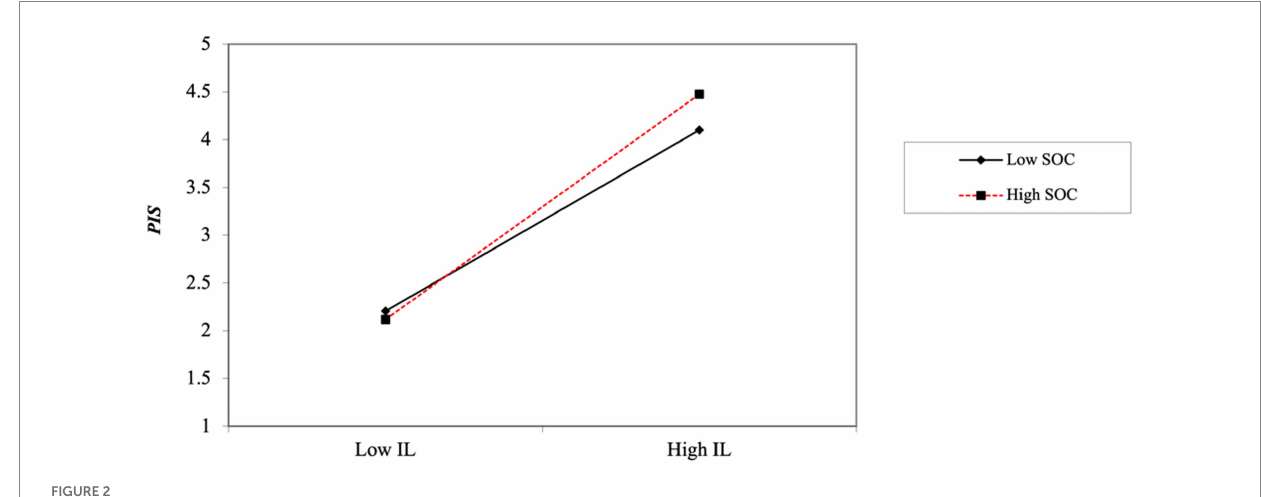
FIGURE 2 Hierarchical regression